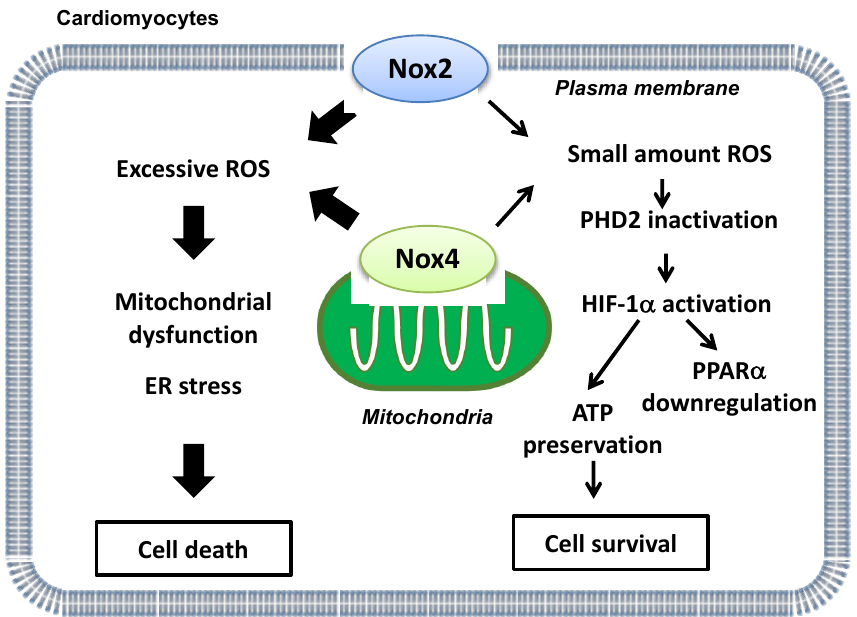
Figure 2. A schematic representation of ‘Yin and Yang’ aspects of Nox2 and Nox4-derived ROS during myocardial I/R injury. Whereas excessive ROS production derived from Nox2 and Nox4 is detrimental ( left side ), basal ROS levels derived from either Nox2 or Nox4 are indispensable for energy metabolism and ATP production during I/R ( right side ).